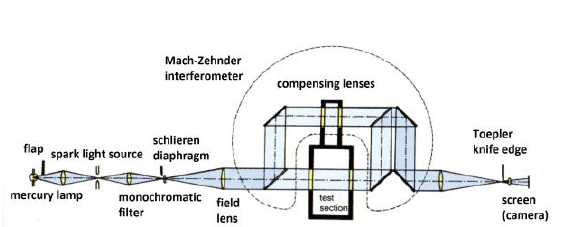
Fig. 2. The scheme of the optical measurements using Mach- Zehnder interferometer.